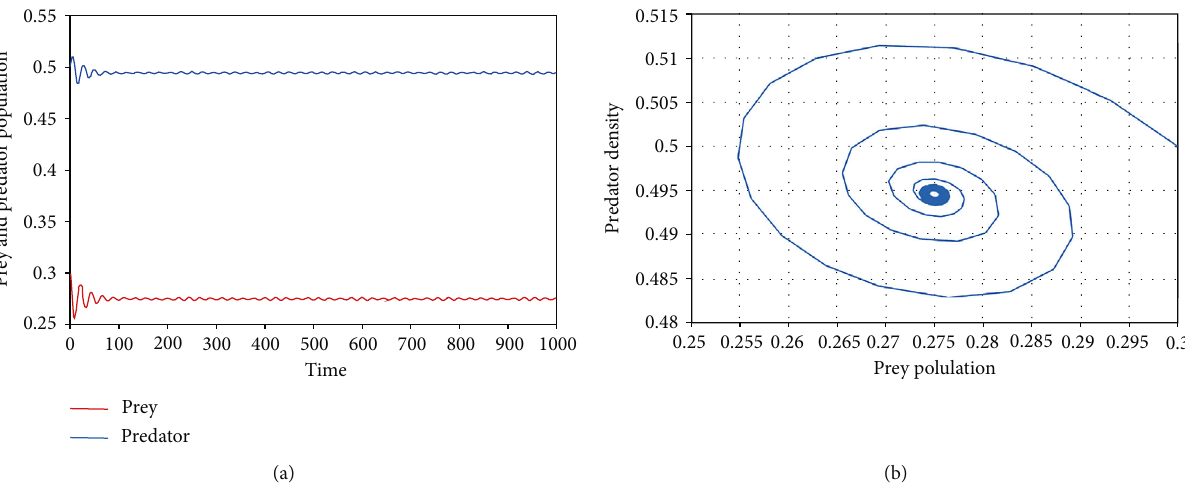
Figure 6: (a) The density of prey population for the parameter values as in Table 2 except c 0 : 01,0 : 07,0 : 1,0 : 14 and (b) the density of predator population for the parameter values as in Table 2 except c and c 2 = 0 : 01,0 : 07,0 : 1,0 : 14